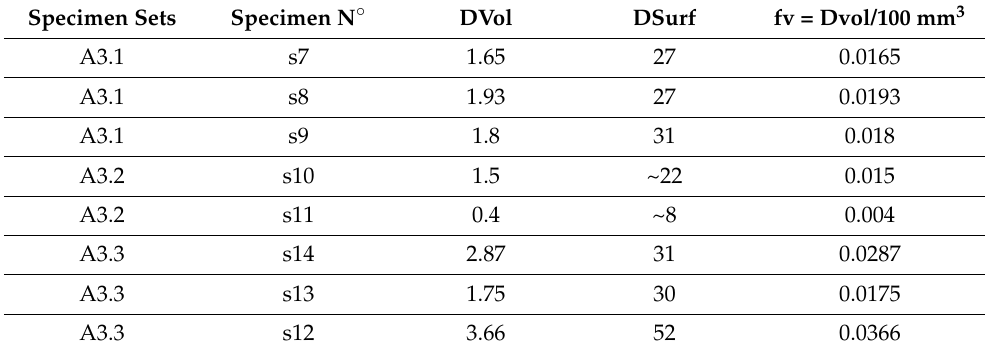
Table 7. Tomography Defect Metrics A3 alloy Set and Porosity